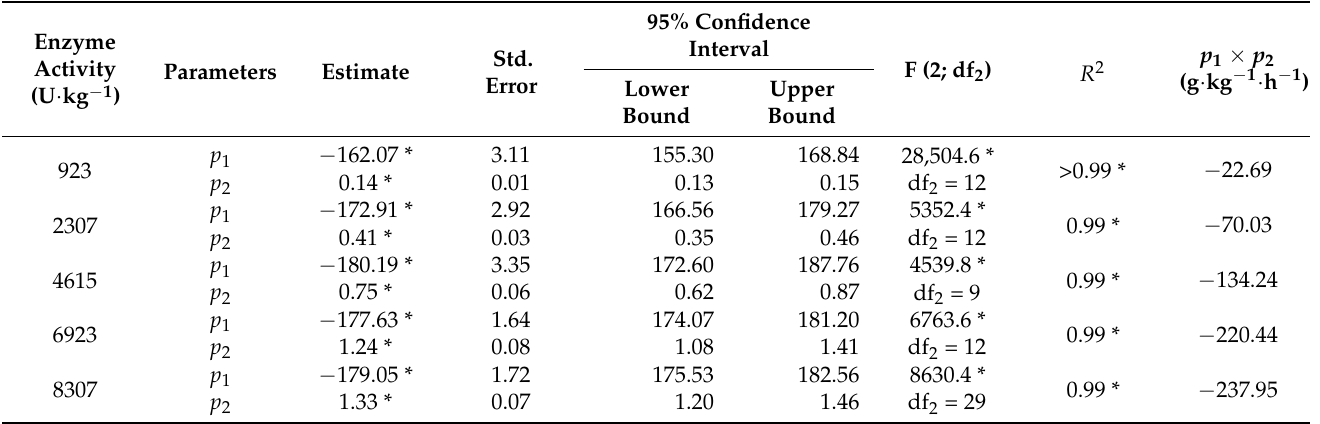
Table 2. Estimated parameters for the saturation model (Equation (7)) for different enzyme activities (rounded for two digits), their standard errors and 95 % confidence intervals together with the